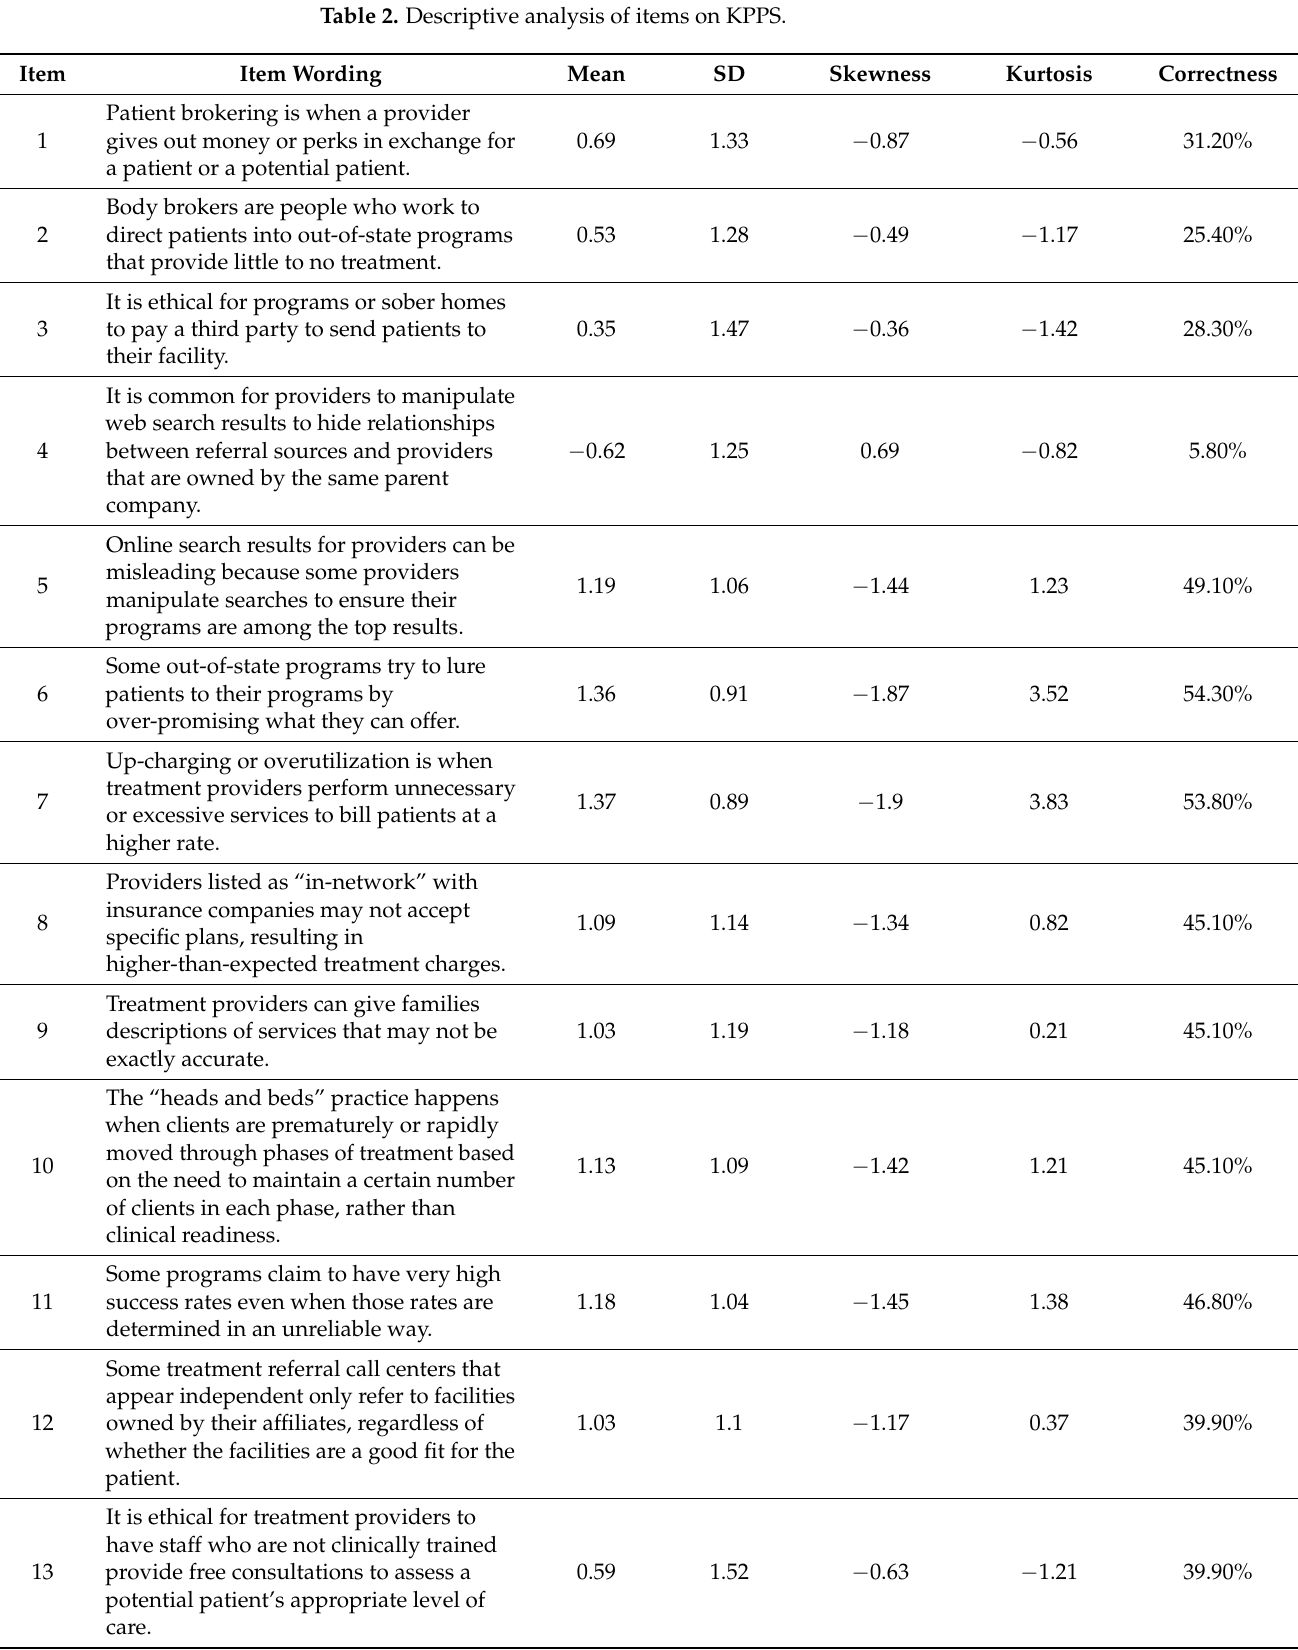
Table 2. Descriptive analysis of items on